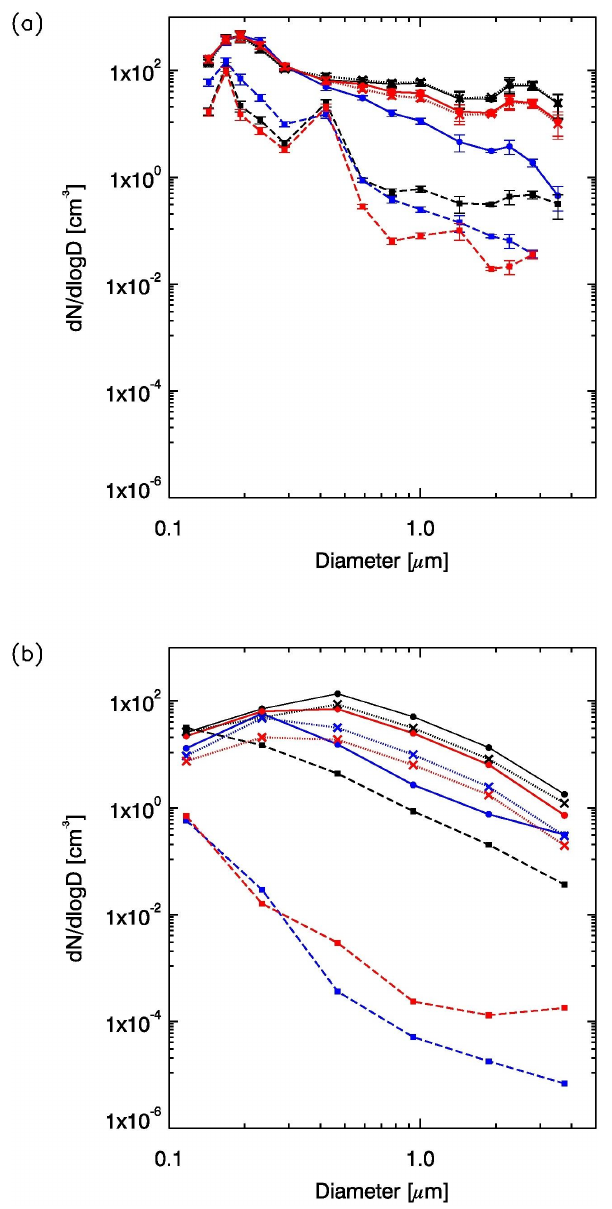
Fig. 13. Particle number size distributions [cm − 3 ] from (a) aircraft measurements (PCASP) and (b) G3 simulations. Different colors denote three regions: (R1, black) longitudes to the west of 20 ◦ W, (R2, red) longitudes between 20 ◦ W and 19.1 ◦ W, and (R3, blue) longitudes eastwards of 19.1 ◦ W. The symbols and linestyles cor- respond to the three flight legs: solid lines with dots show 400m height, dotted lines with crosses 700m height, and dashed lines with squares show 1900m height. Vertical bars in panel (a) show 3-sigma uncertainties associated with the measurements. Note that the 700m flight leg (dotted lines with crosses) can barely be distin- guished from the 400m flight leg in panel (a) , since the size distri- butions are quite similar at these heights. R3 was not investigated during the 700m flight leg and hence does not appear in panel (a) .